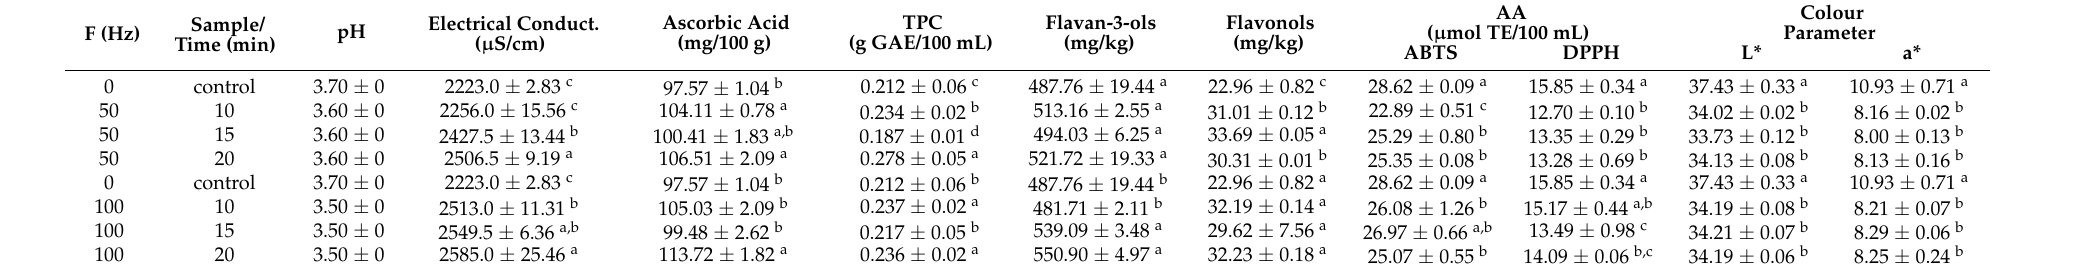
Table 2. Physicochemical parameters, antioxidant activity, and colour parameters of untreated and HVED treated rose hip